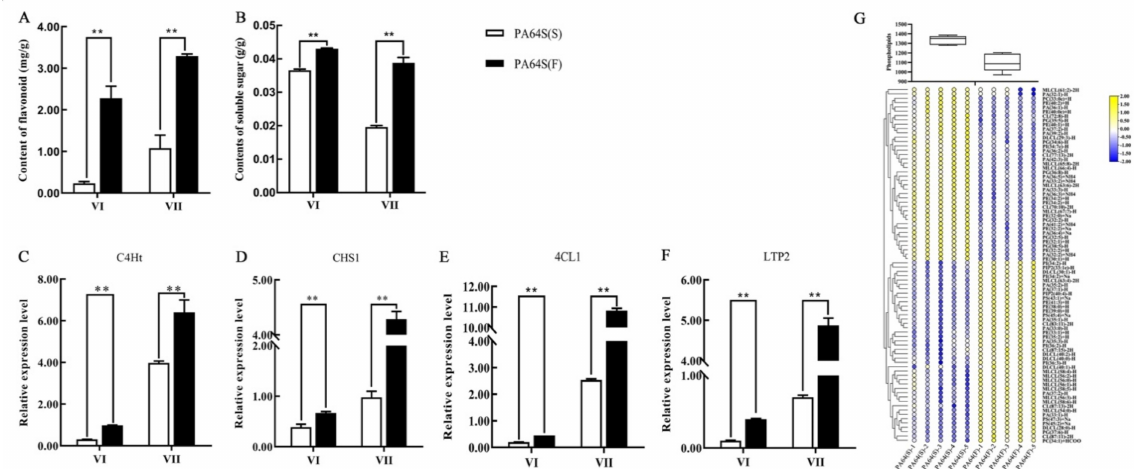
Figure 10. The content of metabolites and relative expression of related genes involved in the regulation of male fertility processes. ( A ) Content of flavonoid, ( B ) content of soluble sugar, ( C ) relative expression level of C4Ht, ( D ) relative expression level of CHS1, ( E ) relative expression level of 4CL, ( F ) relative expression level of LTP2, and ( G ) phospholipid content of phospholipid and different lipid groups in PA64S(S) and PA64S(F) lipid metabolism. The box plot indicates the total content of phospholipids. CL: cardiolipin; DLCL: di-lyso cardiolipin; MLCL: mono-lyso cardiolipin; PA: phosphatidic acid; PC: phosphatidylcholine; PE: phosphatidylethanolamine; PG: phosphatidylglycerol; PI: phosphatidylinositol; PIP2: phosphatidylinositol diphosphate; and PS: phosphatidylserine. Asterisks indicate significant differences revealed by Student’s t -test at p < 0.01